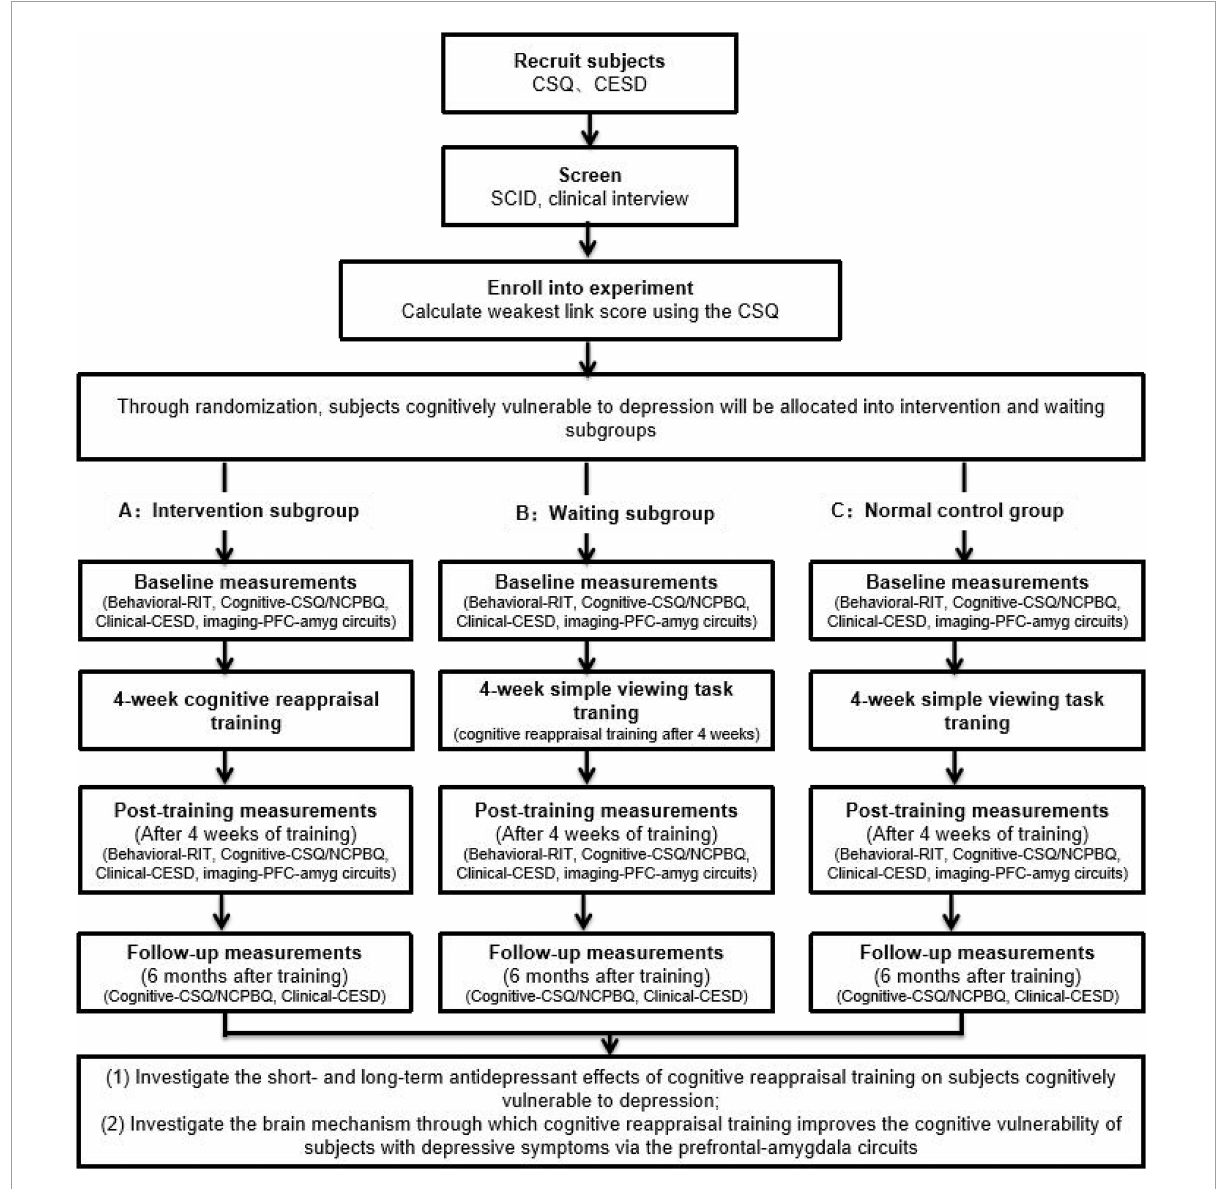
FIGURE2 The flow diagram of the current study summarizing the randomized controlled trial design, recruitment of participants, and collected